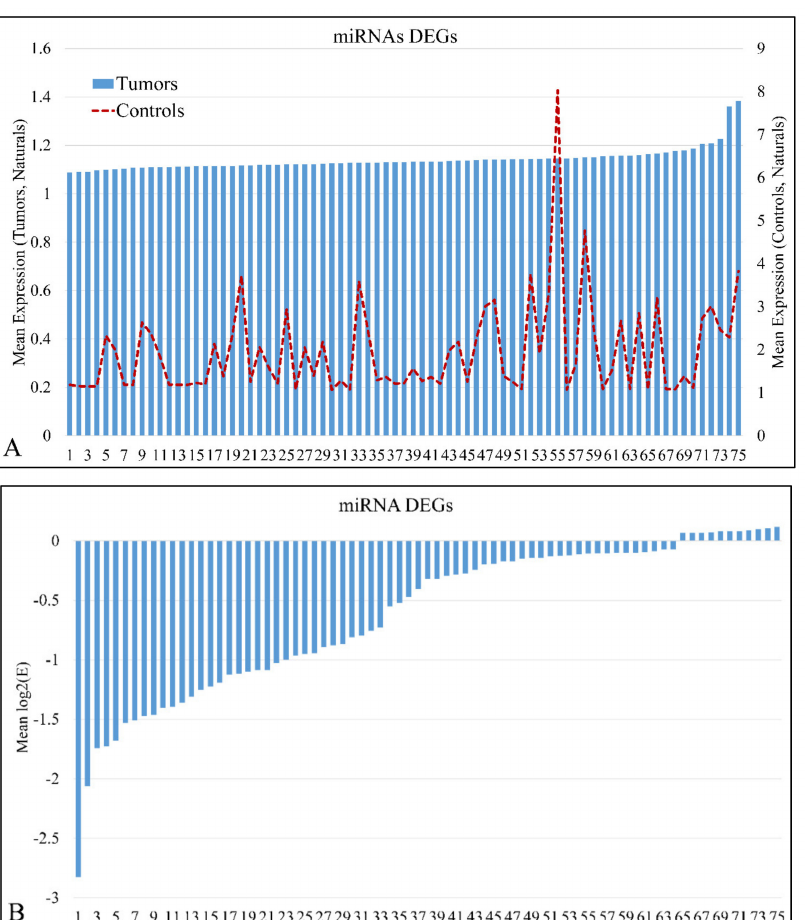
Figure 1. Mean expression of DE miRNAs in ascending order. The miRNAs naturals presented are in the following order (from 1 to 75): hsa-miR-3655, hsa-miR-128, hsa-miR-520a-3p,